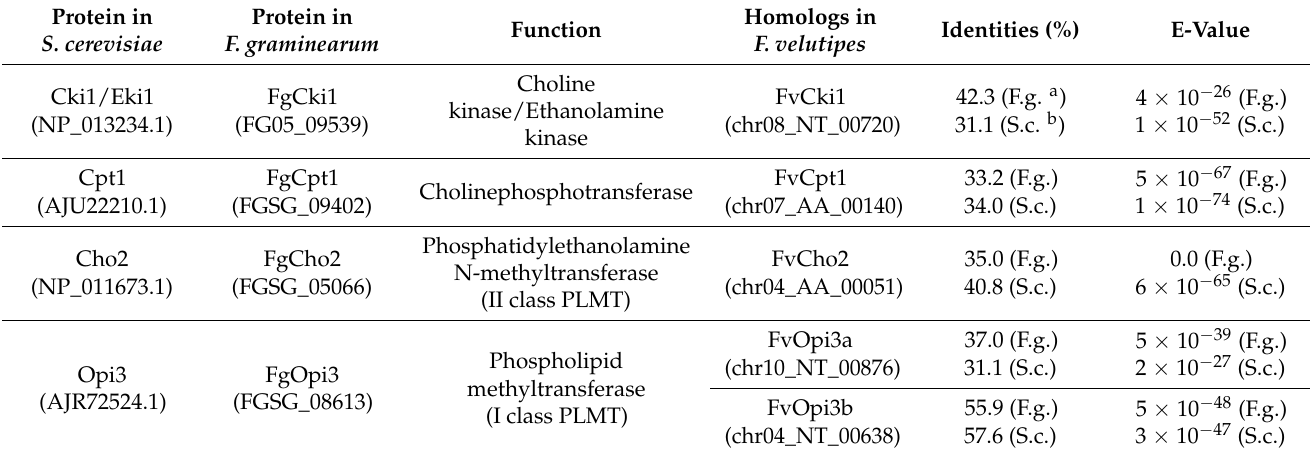
Table 2. Predicted proteins involved in the phospholipid biosynthesis pathways in F. velutipes .